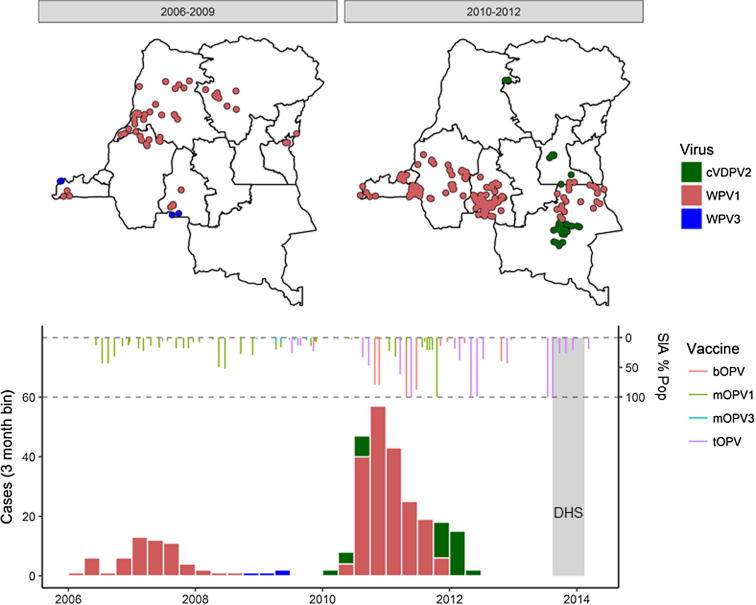
Epidemiology and polio vaccination program history in the DRC. Top panel: the geographic distribution of cases in the periods 2006–2009 and 2010–2012; points are placed randomly in the district where a child was present two weeks prior to the onset of paralysis. Bottom panel: polio AFP case count by three-month bins; above the case counts are bars representing supplemental immunization activities. The grey band shows the period in which the DHS survey was conducted.